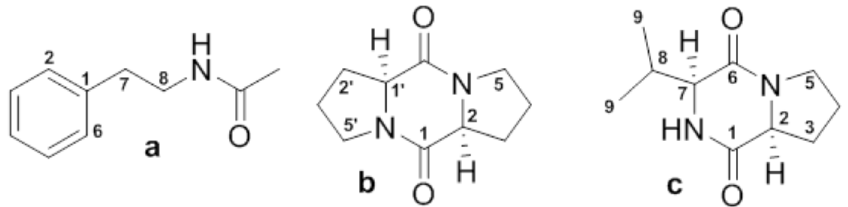
Figure 8. Structures of the compounds Ech 5-4 ( a ), Eea 2-5 ( b ), and Eea 3-2 ( c ) isolated from the crude extract of Bacillus cereus BE23 filtrate.